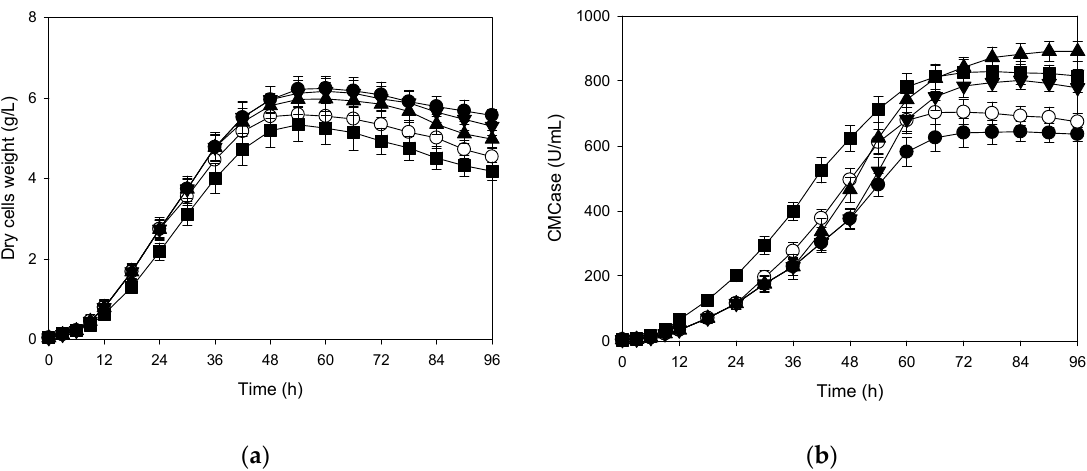
Figure 1. Effects of shift in aeration rate on ( a ) cell growth and ( b ) production of Figure 1. E ff ects of shift in aeration rate on ( a ) cell growth and ( b ) production of carboxymethylcellulase carboxymethylcellulase by E. coli KACC 91335P ( ● , constant at 0.50 vvm; ■ , shift in aeration rate from by E. coli KACC 91335P ( (cid:8) , constant at 0.50 vvm; (cid:4) , shift in aeration rate from 0.50 to 0.95 vvm at 24 h; (cid:78) , shift in aeration rate from 0.50 to 0.95 vvm at 36 h; (cid:72) , shift in aeration rate from 0.50 to 0.95 vvm at 0.50 to 0.95 vvm at 24 h; ▲ , shift in aeration rate from 0.50 to 0.95 vvm at 36 h; ▼ , shift in aeration rate from 0.50 to 0.95 vvm at 48 h; and ○ , constant at 0.95 vvm). 48 h; and , constant at 0.95 (cid:35)